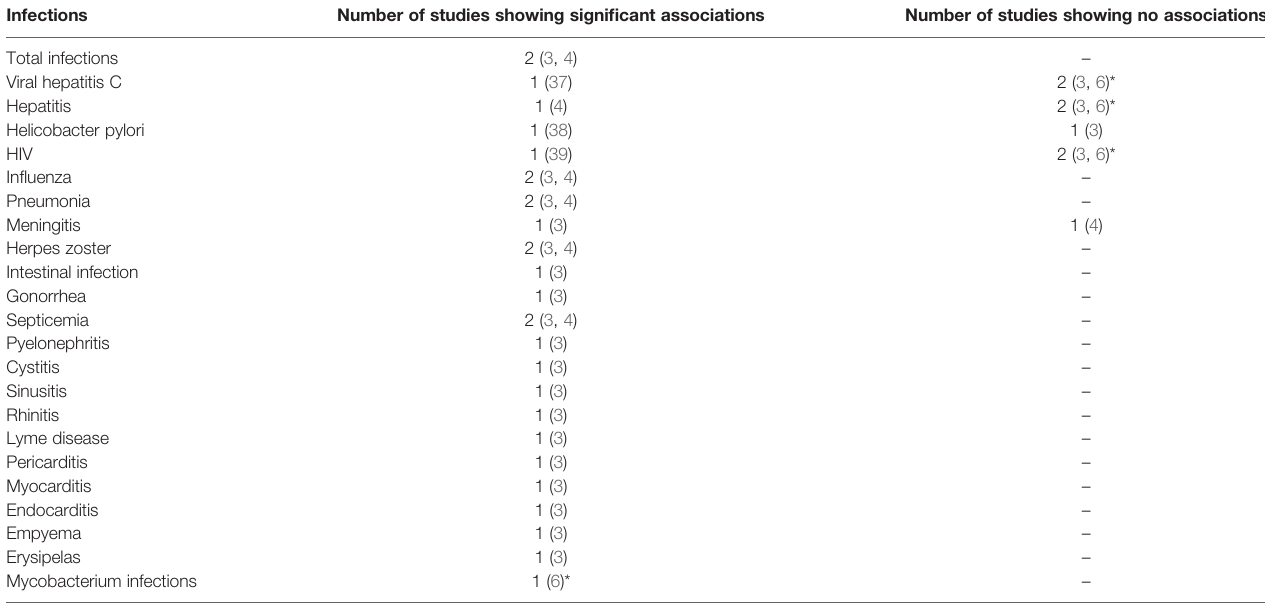
TABLE 2 | Infections associated with